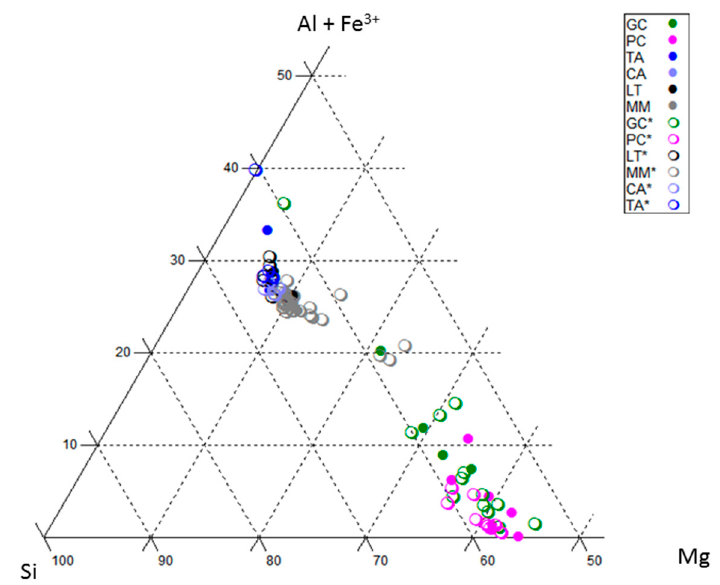
Figure 12. Ternary plot showing the proportions of Si and octahedral cations (Al + Fe 3+ and Mg) from the structural formulae of both the smectites analyzed in this work (Table 3) and those from bibliography data (Table 4). GC: Green Clays; PC: Pink Clays. Samples from Table 3: TA, Tamame; CA, Cortijo de Archidona; LT, Los Trancos; MM, Morrón de Mateo. Samples from Table 4 have the same labels (with *).